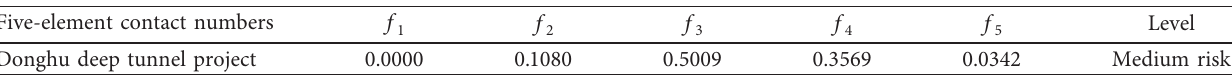
Table 11: The results of Donghu Deep Tunnel Project’ five-element contact numbers.